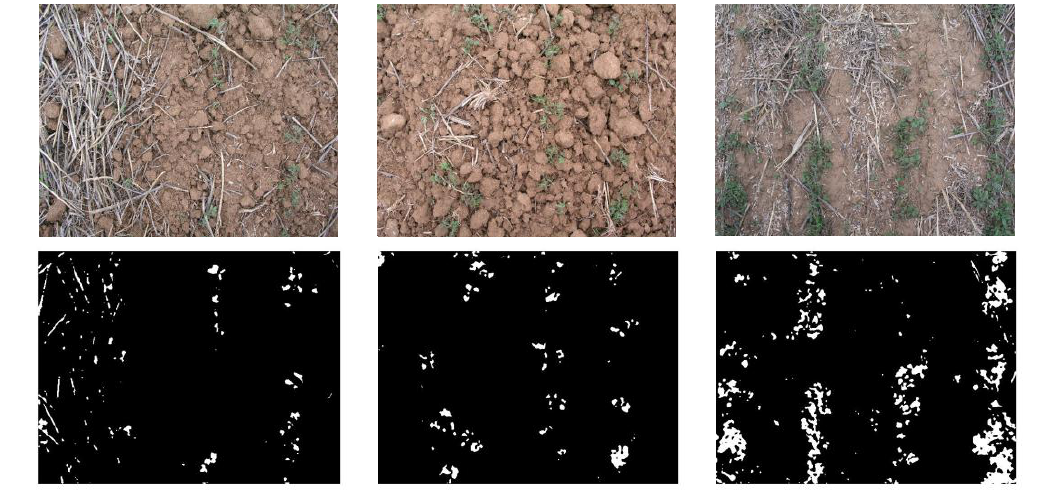
Figure 3. Original and binary images of